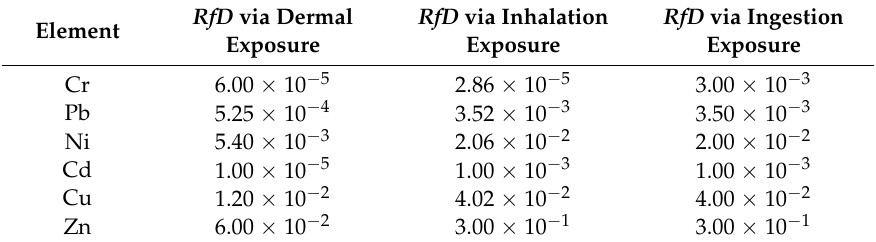
Table 4. Reference doses of heavy metals through three exposure pathways (mg · (kg · d) − 1 ). RfD via Dermal Element